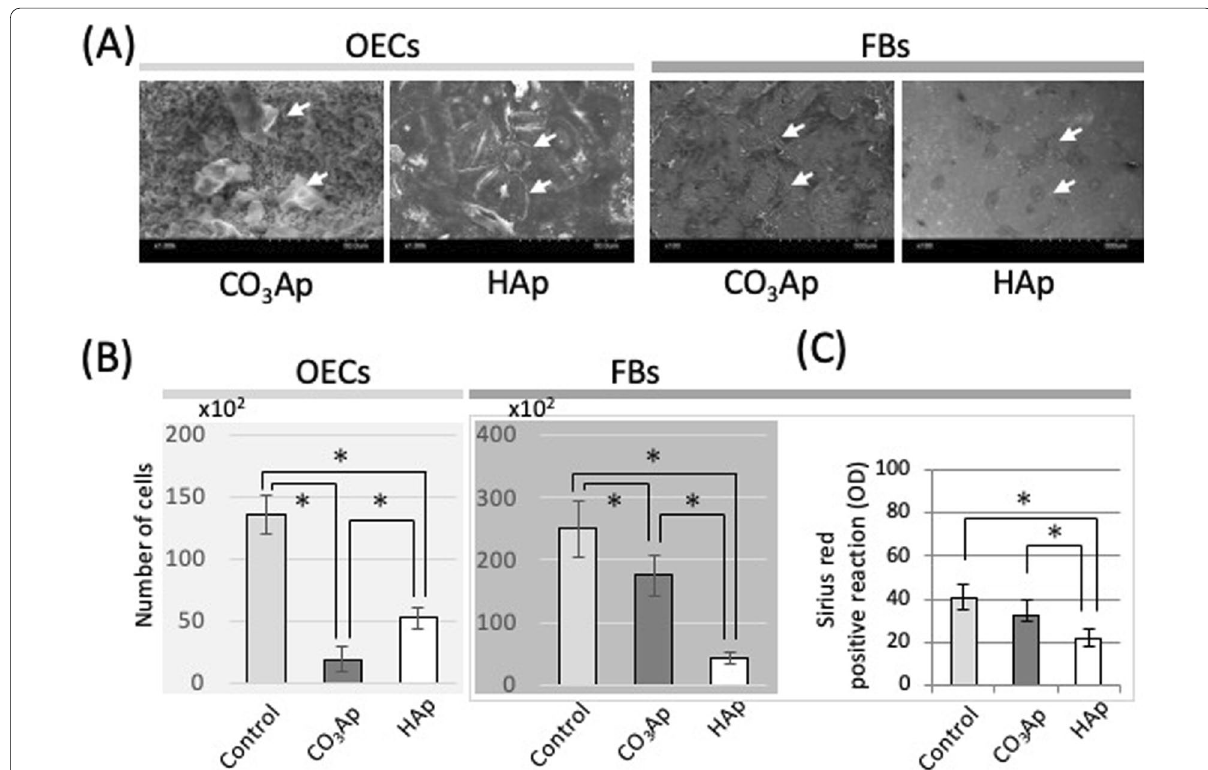
Fig. 2 Direct effects of carbonate apatite on OECs and FBs. A Scanning electron microscopy images of OECs or FBs on the materials. B The number of cells on the materials (n 6, * p < 0.05). C Quantification of Sirius red staining for collagen expression of FBs on the materials. Control: culture dish, =